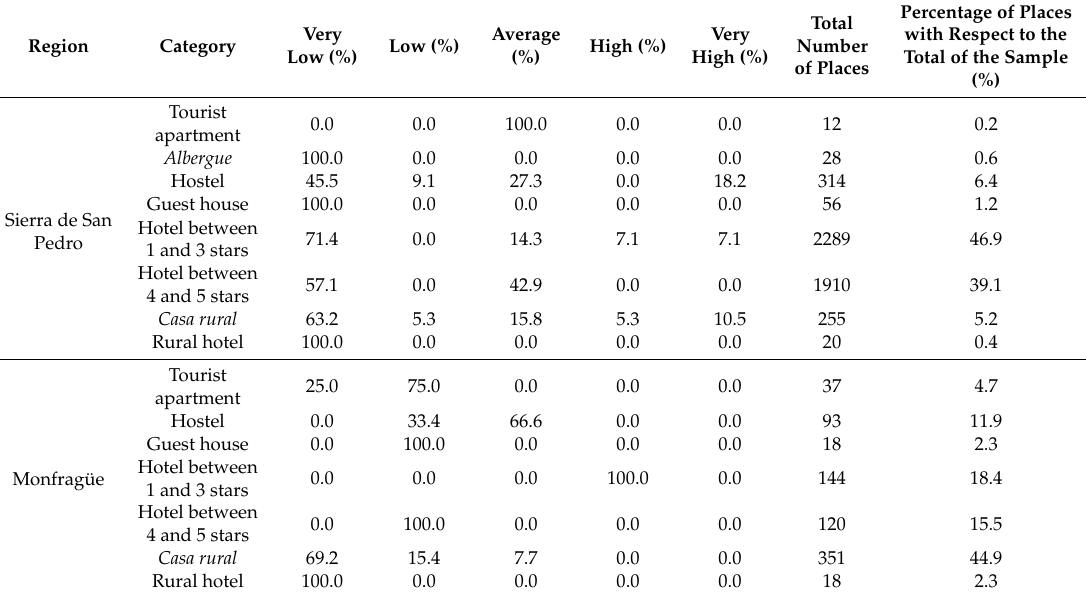
Table 9. Incidence of the hunter by type of